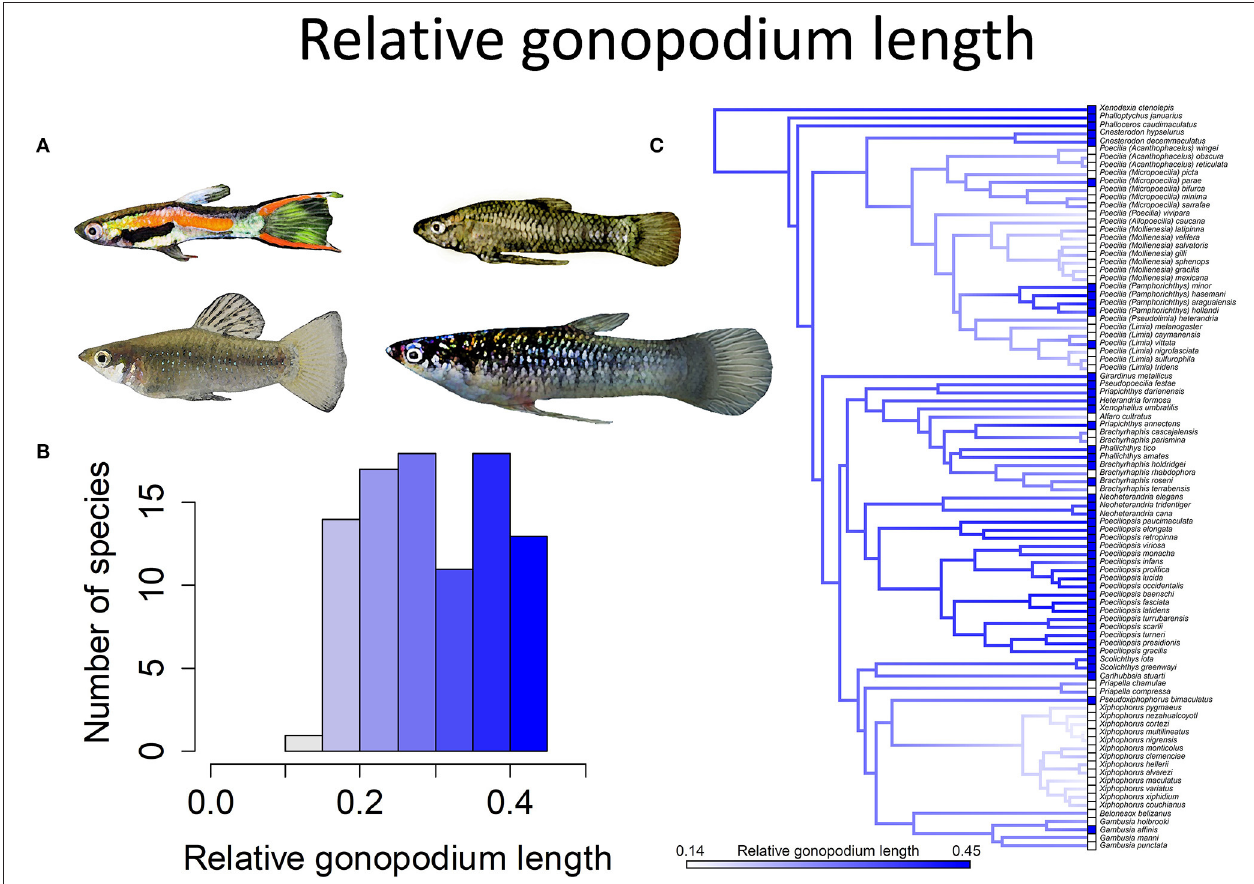
FIGURE 6 | Relative gonopodium length in the family Poeciliidae ranges from 14 to 45% of male standard length. (A) Males of Poecilia wingei and Limia perugiae (pictured left) have relatively short gonopodia while males of Phalloptychus Januarius and Poeciliopsis elongata (pictured right) have relatively long gonopodia. (B) Frequency histogram of male gonopodium length ( n = 92). (C) Ancestral state reconstruction of relative gonopodium length as a continuous character using the contMap function in the R package phytools, which estimates the Maximum likelihood ancestral states at all internal nodes and interpolates the states along each edge. The phylogeny tips depict a binary categorization of relative gonopodium length (i.e., short vs. long). The most likely ancestral state of the family, when treated as a binary character, is that of a long gonopodium ( Furness et al.,